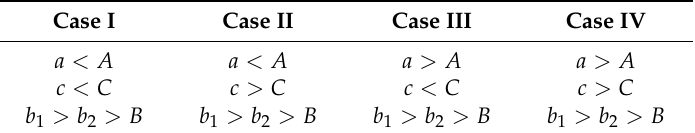
Table 1. The numerical simulation cases. a , A = growth rates; b 1 , b 2 , B = bone marrow microenvironment sensitivity; c , C = death rates; a , b 1 , b 2 , c = normal stem cell parameters; and A , B , C = abnormal (leukemic) stem cell parameters. Case I Case II Case III Case IV a <